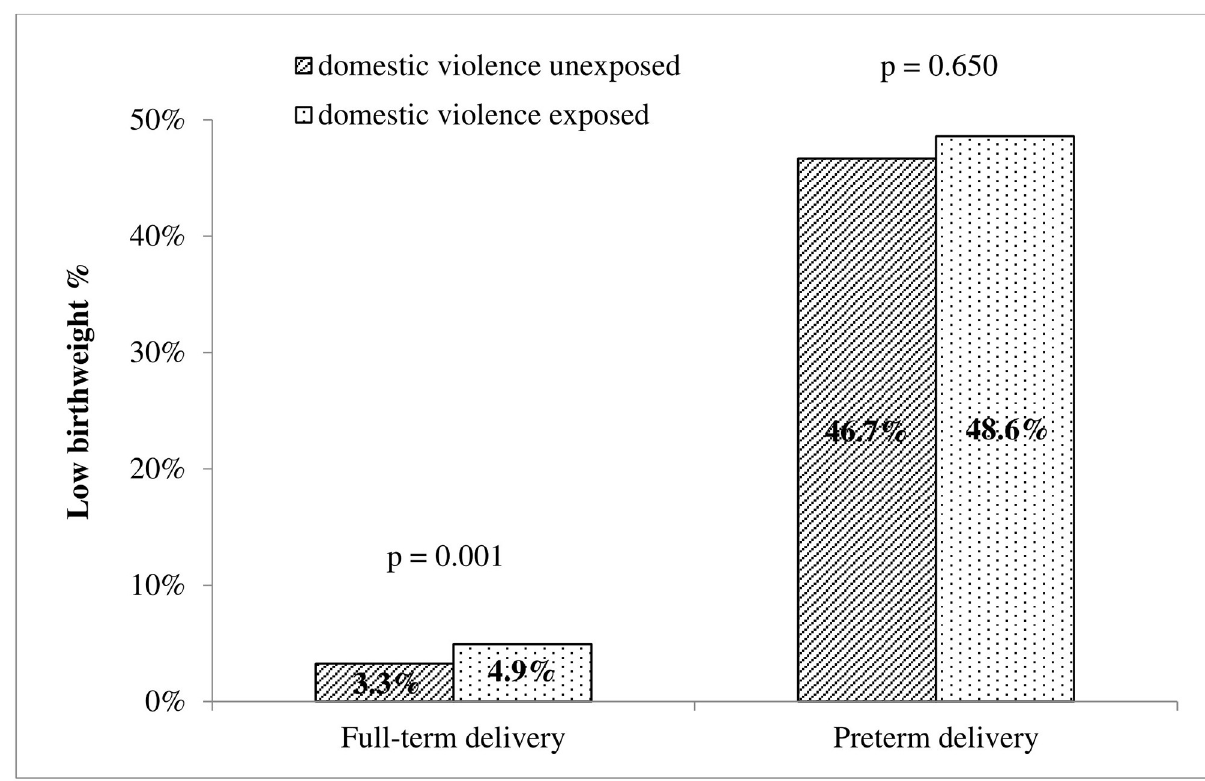
Fig 2. Percentage of low birthweight by domestic violence status and preterm/full-term delivery.